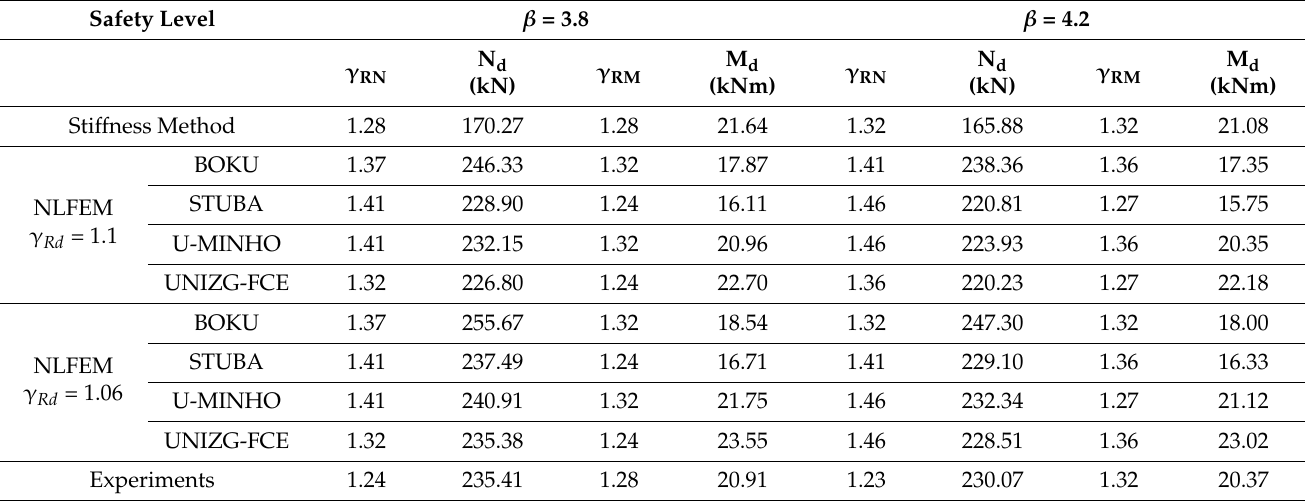
Table 6. Global resistance factor and design resistance according to ECOV